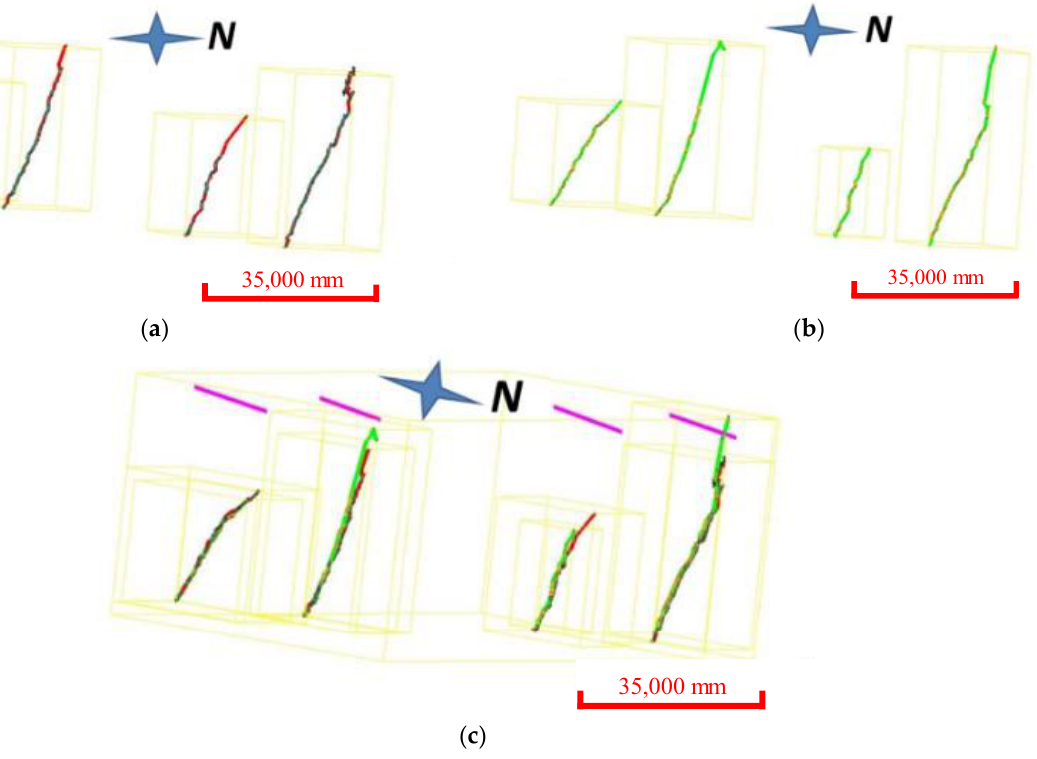
Figure 16. Comparison of typical cross-sections of the 3D laser scanning. ( a ) Typical sections in 2019. ( b ) Typical sections in 2020. ( c ) Comparison of typical sections.